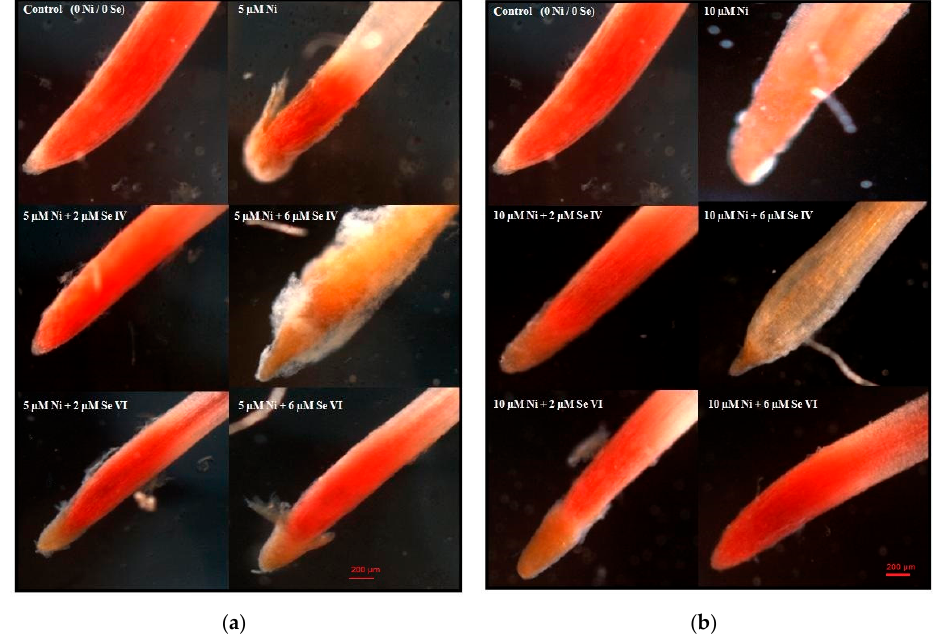
Figure 4. Influence of Se supplementation on the viability of root tips (staining with the 2,3,5- triphenyltetrazolium chloride (TTC) method) of Ni-exposed lettuce after 14 days of exposure. ( a ) Root tips of plants grown at 5 µM Ni and supplemented with Se; ( b ) root tips of plants grown at 10 µM Ni and supplemented with Se. Table 1. Effect of Se supplementation on Ni and Se concentrations in the shoots and roots of Ni- exposed lettuce after 14 days of exposure.